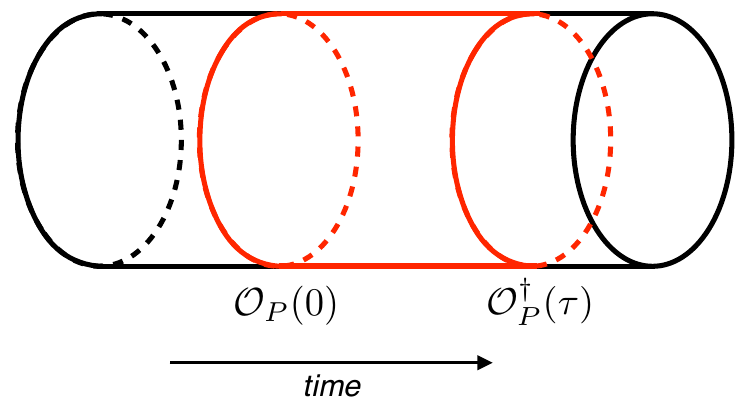
Figure 1 . A long string wound around the cylinder is created by a Polyakov loop simulations a (cid:12)nite volume spectrum of the worldsheet theory is determined from the exponential fallo(cid:11) of two-point correlators,